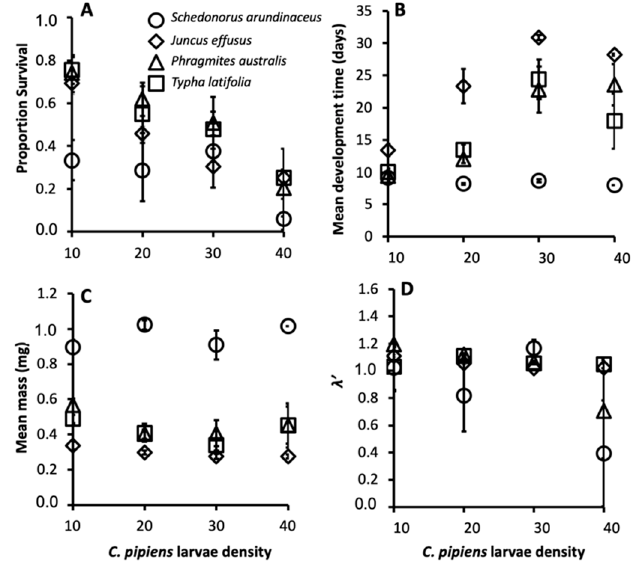
Figure 2. Mean female survivorship ( A ), female development time ( B ), female mass ( C ), and λ ’ ( D ) for C. pipiens provisioned with each detritus species. Error bars are ± Standard Error of the Mean (SEM).